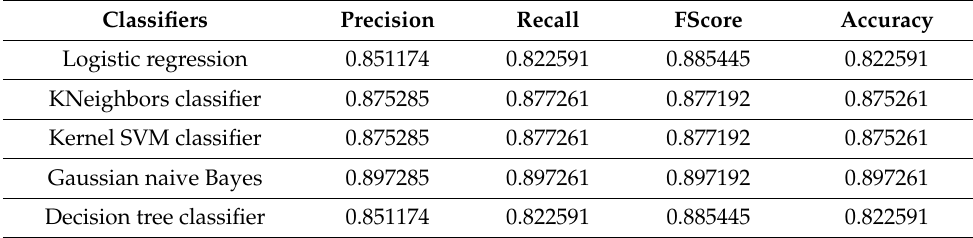
Table 23. Random forest classifier metrics before feature